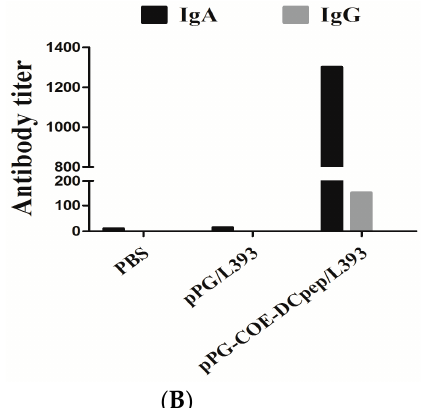
Figure 1. Specific secretory immunoglobulin (Ig) levels. The piglets received pPG-COE-DCpep/L393 (10 10 CFU in 1 mL of phosphate-buffered saline (PBS) and PBS alone) for the different vaccination programs, via an oral route; Group A (1 mL pPG-COE-DCpep/L393 /Day 0); Group B (2 mL pPG-COE- DCpep/L393 /Day 0); Group C (2 mL pPG-COE-DCpep/L393 /Day 2); Group D (4 mL pPG-COE- DCpep/L393 /Day 2); Group E (1 mL PBS). ( A ) Mucus extracts were collected using rectal swabs from the groups administered with pPG-COE-DCpep/L393 on days 3, 5, 7, 9, and 11 post- vaccination . The results represent the IgA titer ± standard errors of the means in each group. Serum was collected from the groups administered with pPG-COE-DCpep/L393 on days 3, 5, 7, 9, and 11 post- vaccination . The results represent the IgG titer ± standard errors of the means in each group. ( B ) The immune effects of pPG-COE-DCpep/L393 , pPG/L393 , and PBS. The piglets received 2 mL pPG-COE-DCpep/L393 , pPG/L393 (10 10 CFU in 1 mL of PBS), and PBS alone, for the different vaccination programs via an oral route. Mucus extracts were collected using rectal swabs from different groups on five days post- vaccination . The results represent the IgA titer ± standard errors of the means in each group. Serum